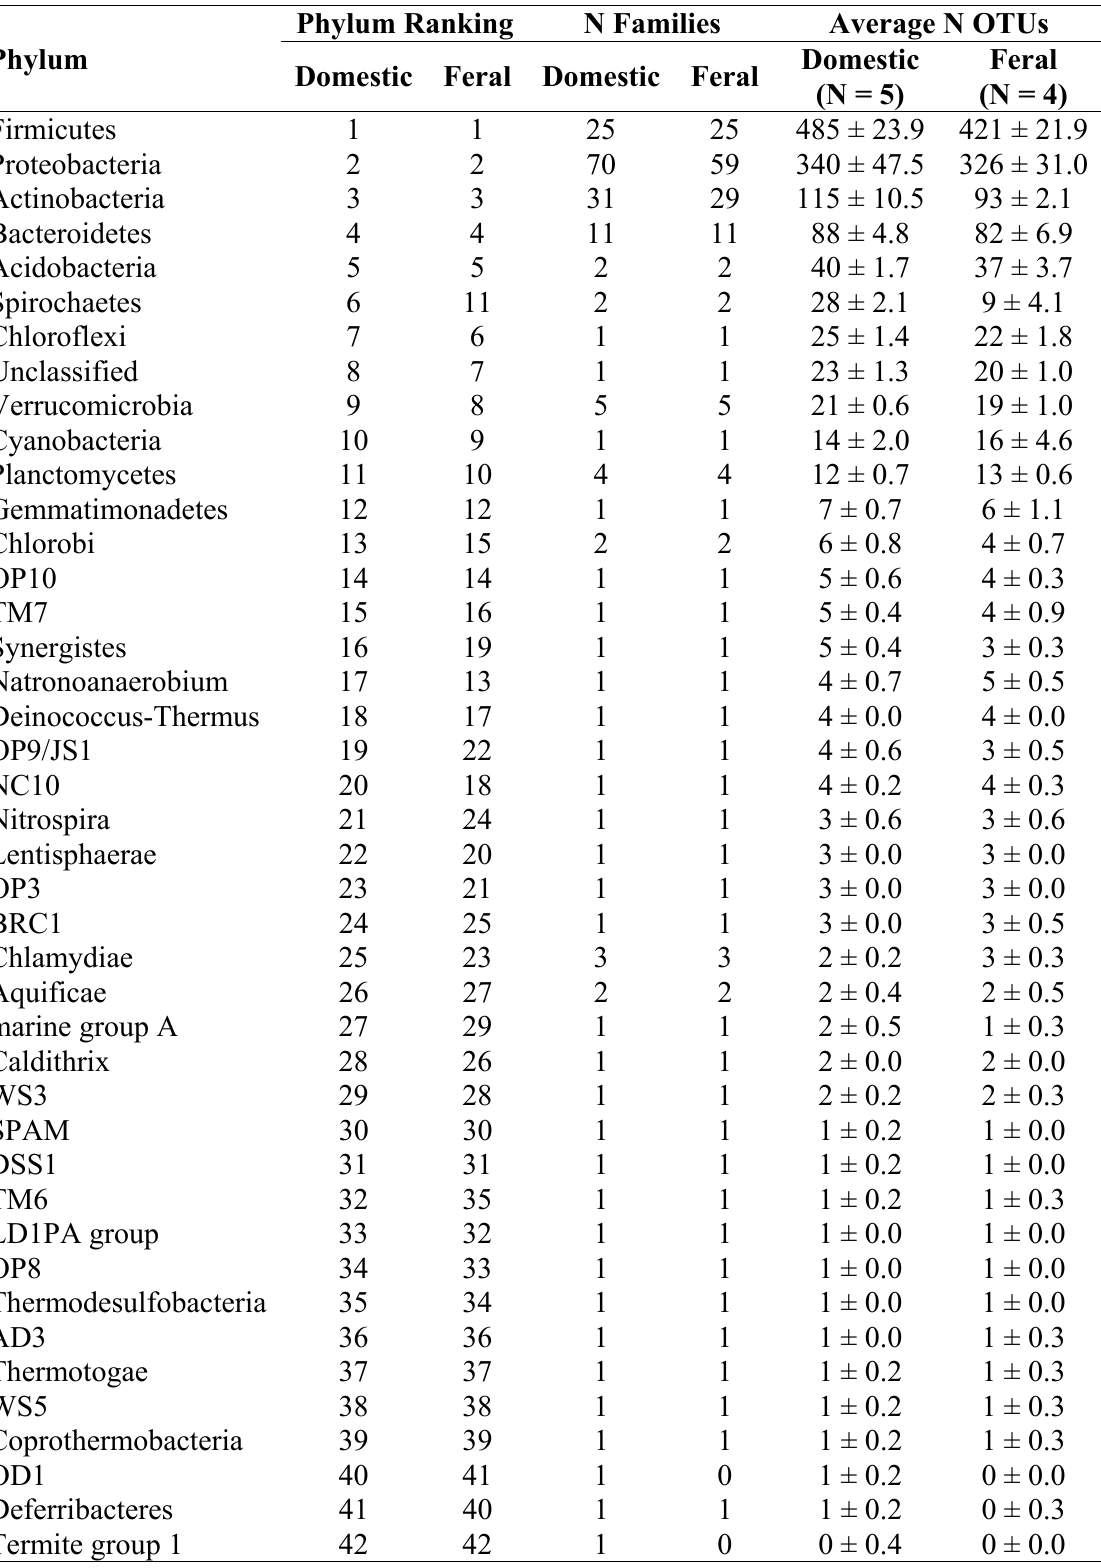
Table S1. Phylum ranking, number of families and average number of bacterial OTUs (± s.e.) in domestic and feral